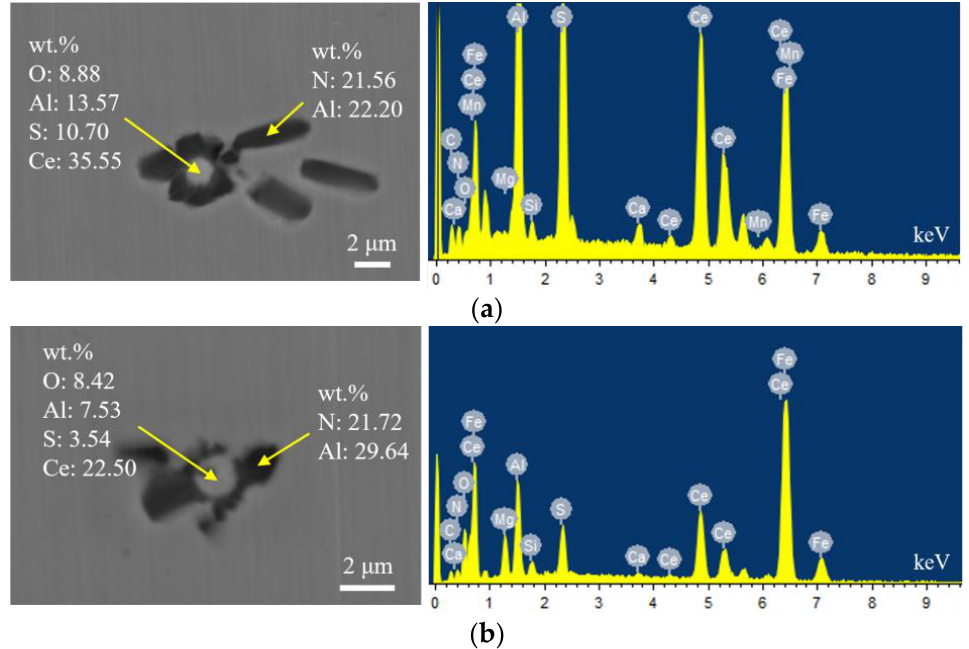
Figure 8. Typical morphology and energy spectrum of inclusions in the steel with 30 ppm Ce content. ( a ) Inner layer: CeAlO 3 -Ce 2 O 2 S, Outer layer: AlN, ( b ) Inner layer: CeAlO 3 -Ce 2 O 2 S, Outer layer: AlN.